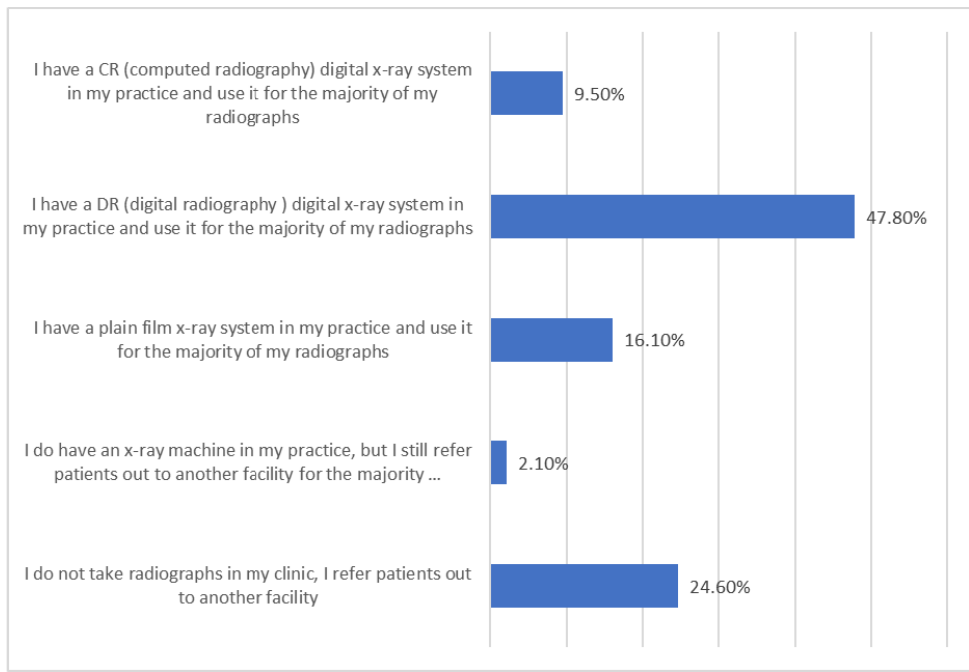
Figure 2. Original (Before Recoding) Distribution of Item Q7.